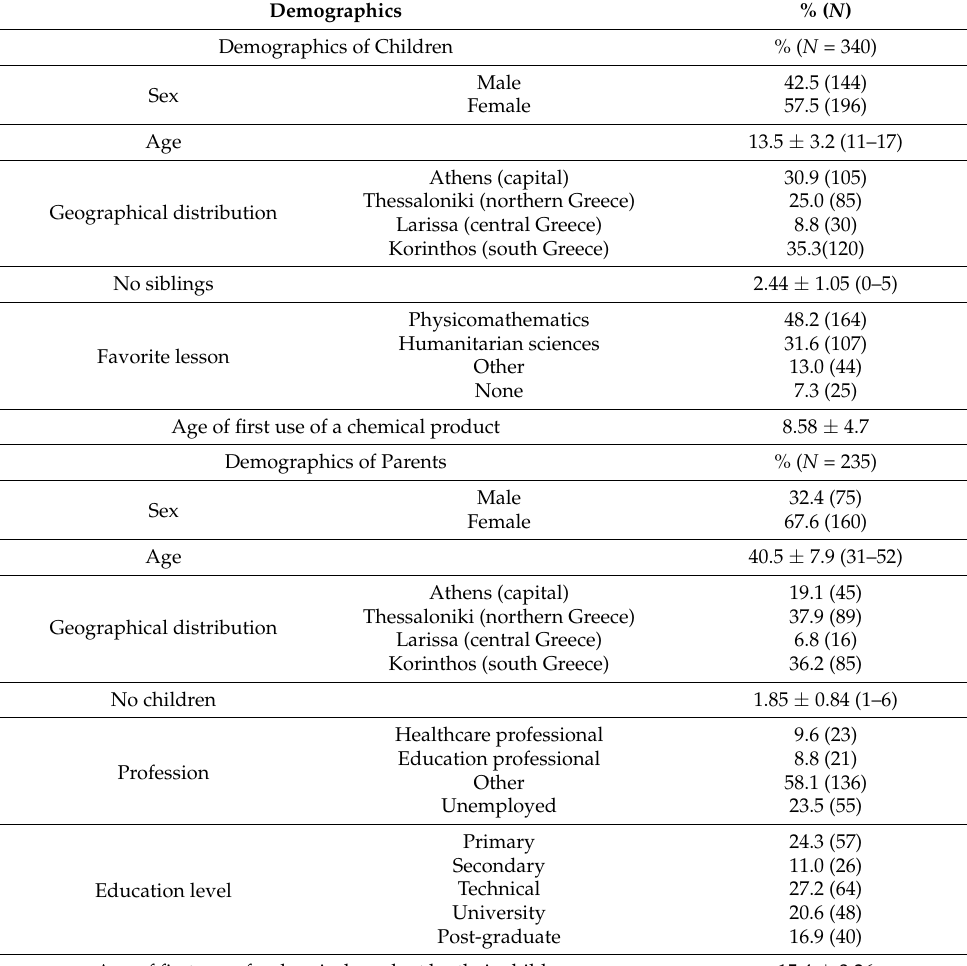
Table 1. Demographics of the study